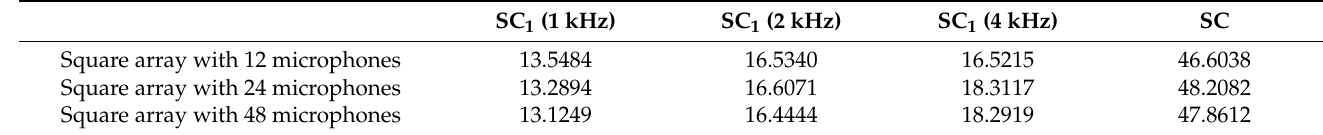
Table 6. Obtained values of scoring functions for each version of the square